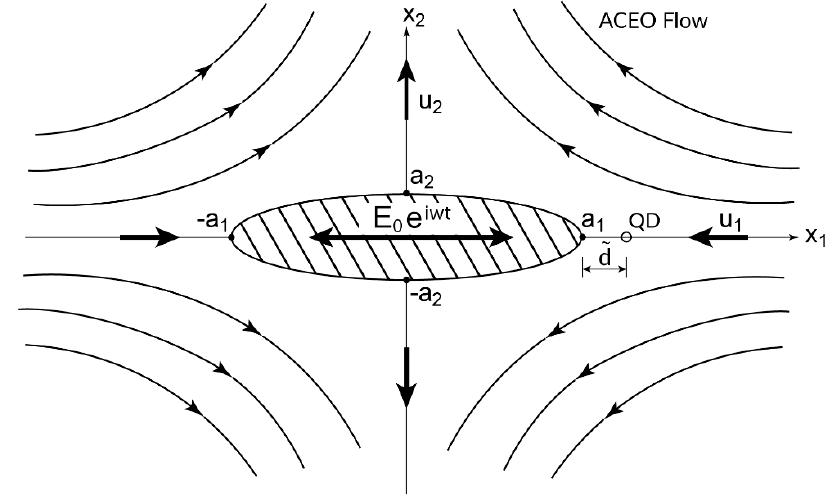
Figure 1. Schematic quadrupole ACEO flow field induced around a tri-axial ellipsoidal nano-antenna by an AC electric field acting along the longitudinal x 1 axis and displaying the position of a free QD at a distance (cid:101) d from the nearest stagnation